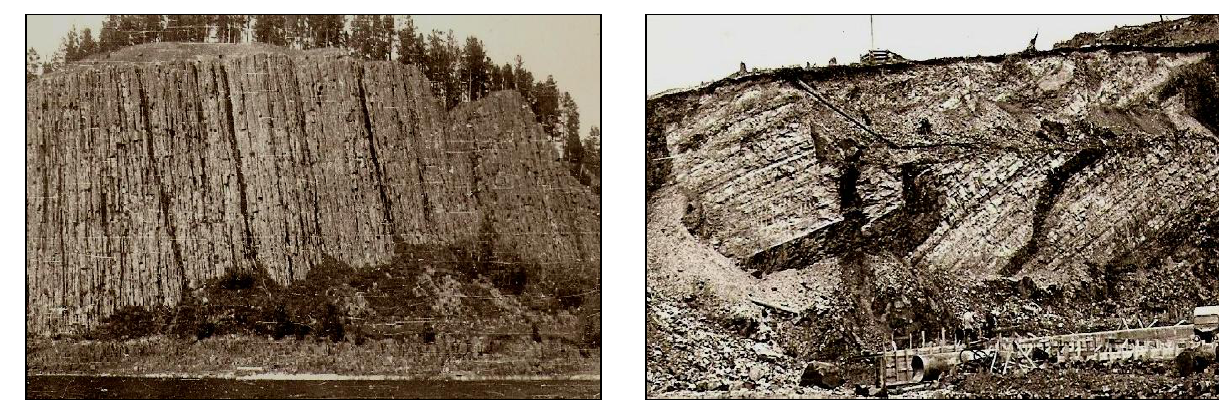
Fig. 3. The character of interaction between the diabase rocks and enclosing rocks of the Kat suite of Carboniferous in the area of Ust-Ilim power plant ( F. N. Leshchikov